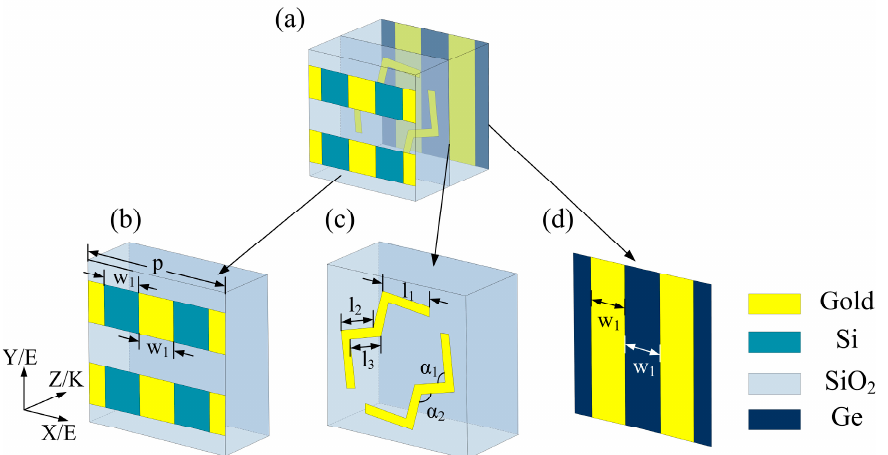
Figure 1. Schematics diagrams of the unit cells of the proposed multifunctional polarization metasurface. ( a ) the top layer, ( b , c ) the middle layer, and ( d ) the bottom layer.